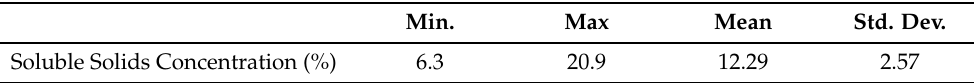
Table 2. Soluble solids reference values statistics